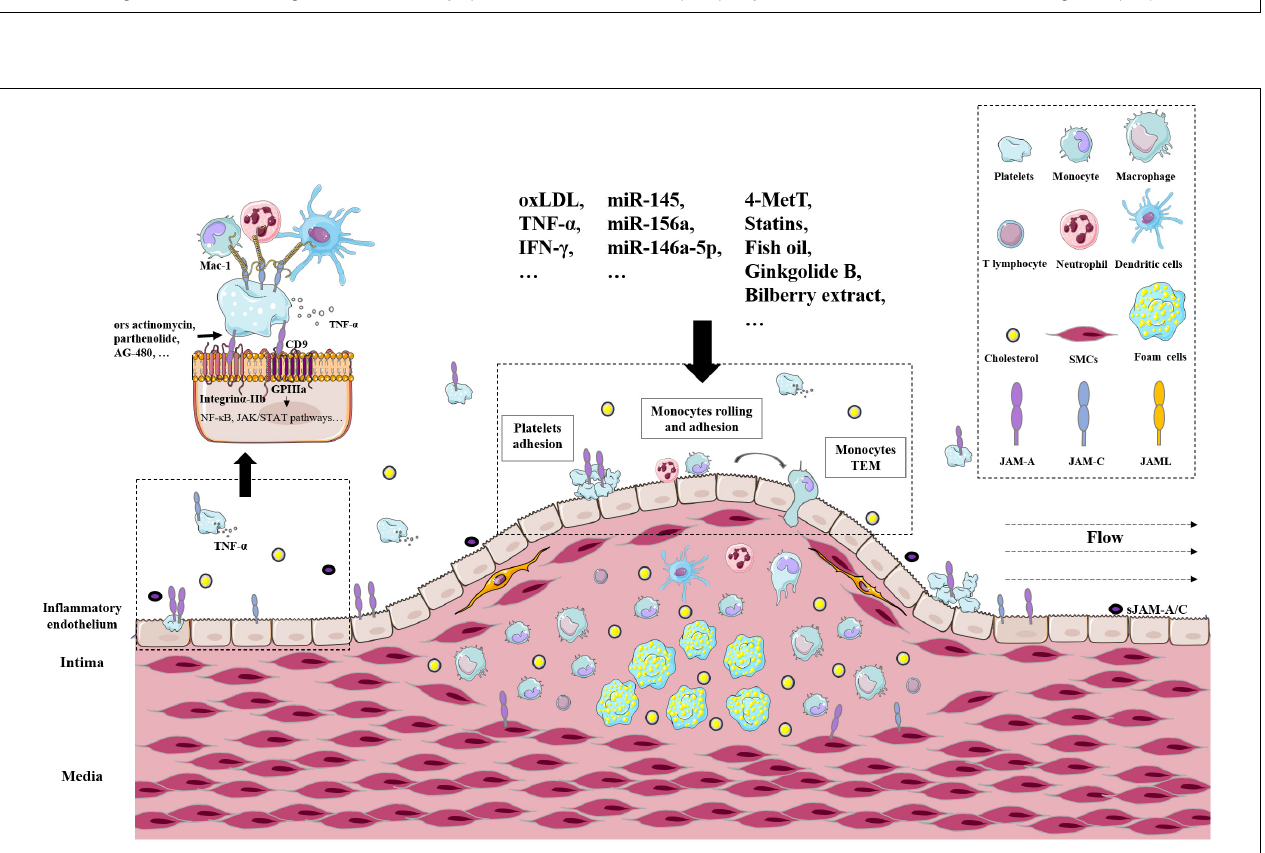
FIGURE 2 | The roles of JAMs in atherosclerosis arteries. Representative receptors, pathways, and regulators of JAMs in atherosclerotic plaques. Related cell types include platelets, leucocytes, endothelial cells, and vascular smooth muscle cells.